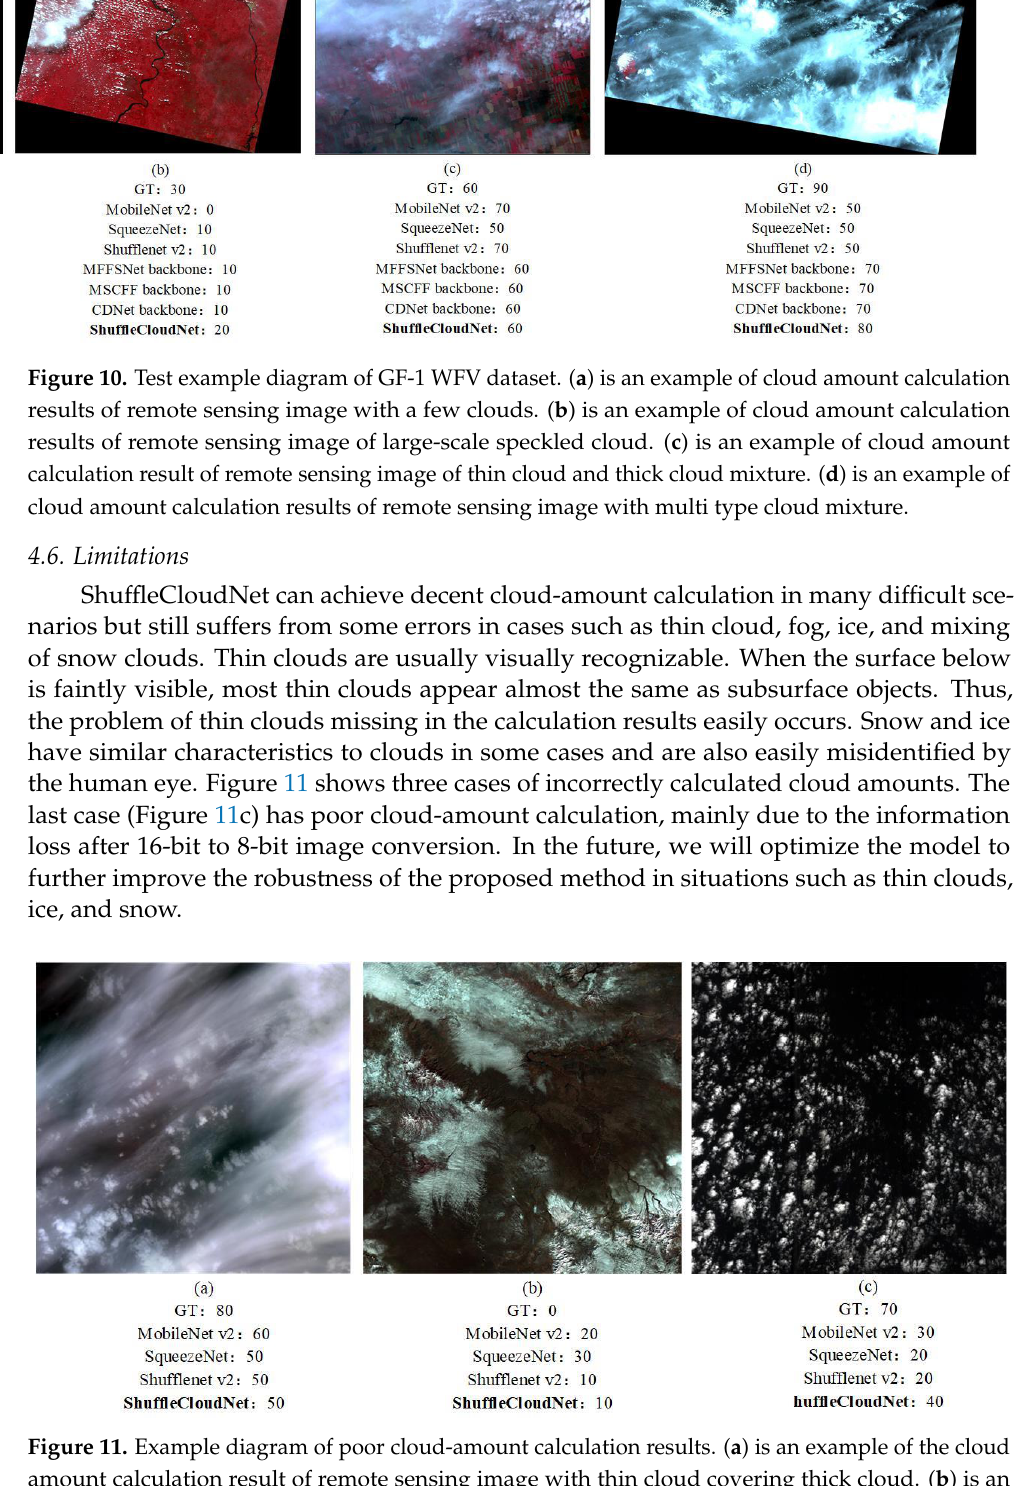
Figure 9. Test example diagram of AIR-CD dataset. (a) is an example of cloud amount calculation result of remote sensing image of thin cloud and thick cloud mixture. (b) is an example of the cloud amount calculation result of remote sensing image in the sea land scene. (c) is an example of the cloud amount calculation result of remote sensing image in the evening time. (d) is an example of cloud amount calculation result of remote sensing image of speckled cloud.